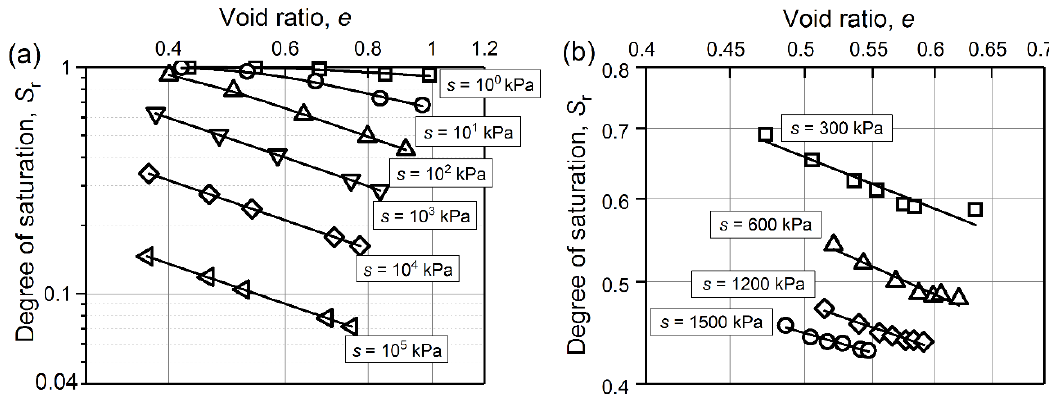
Figure 9. Hydro-mechanical coupling curves in the log e –log S r plane: ( a ) resulting from hydraulic stress (data from Salager et al. [36]); ( b ) resulting from mechanical stress (data from Sun and Sun [41]). Table 3. Values of the parameters at different values of constant suction.